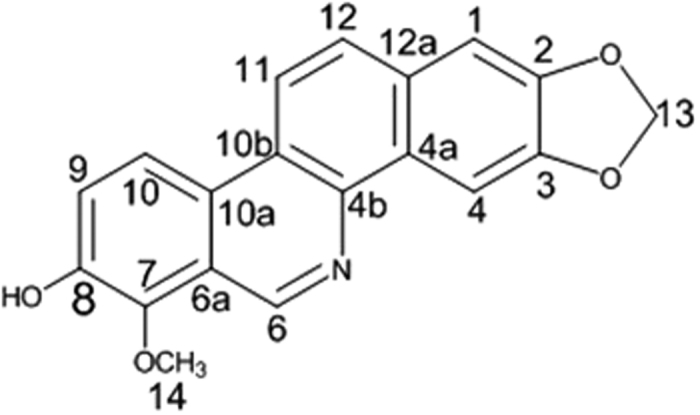
Chemical structure of decarine (18)34.